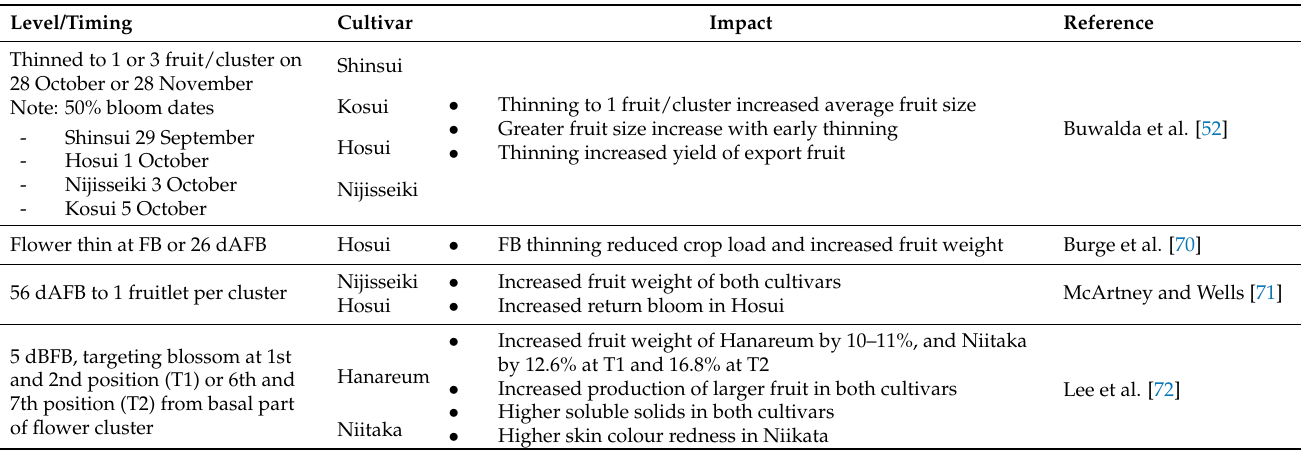
Table 5. Summary of findings on the impact of hand thinning of